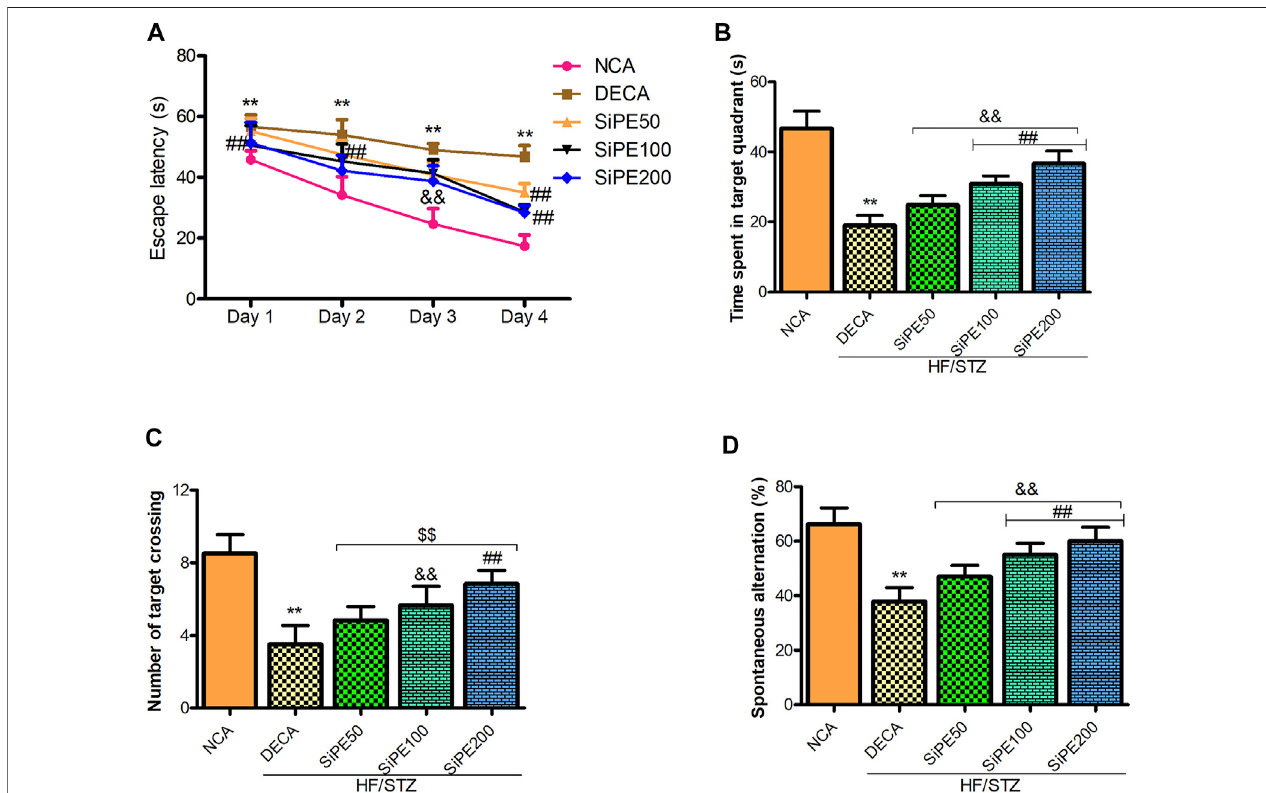
FIGURE3| EffectofSiPEtreatmentonbehaviouralparametersinHF/STZ-induceddiabeticencephalopathicrats.SiPEtreatmentatdoseof50,100or200 mg/kg signi fi cantly improved (A) escape latency, (B) time spent in the target quadrant, (C) number of target crossing and (D) spontaneous alternation compared to DECA group. Data are presented as mean ± SD ( n (cid:2) 6) and one-way ANOVA test was applied. ** p < 0.001 indicates statistical signi fi cance compared to NCA group. ## p < 0.001, && p < 0.01 and $$ p < 0.05 indicate statistical signi fi cance compared to DECA group.